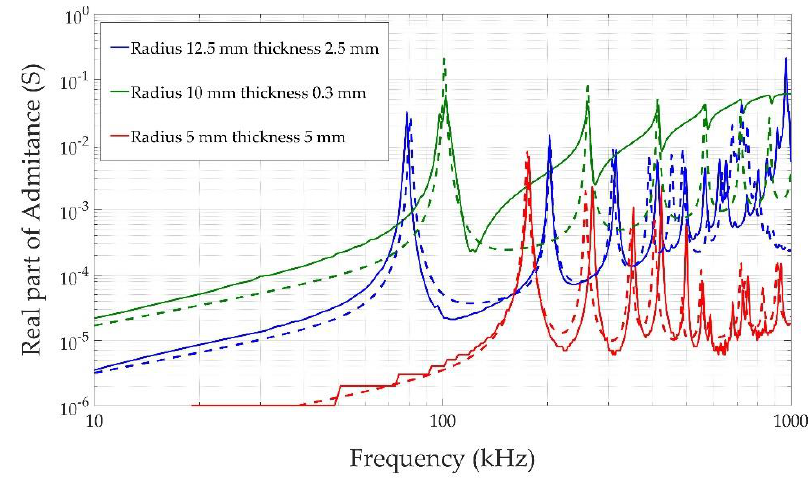
Figure 6. Experimental (continuous line) and simulated (dashed line) admittance for three freely vibrating piezoelectric ceramics.